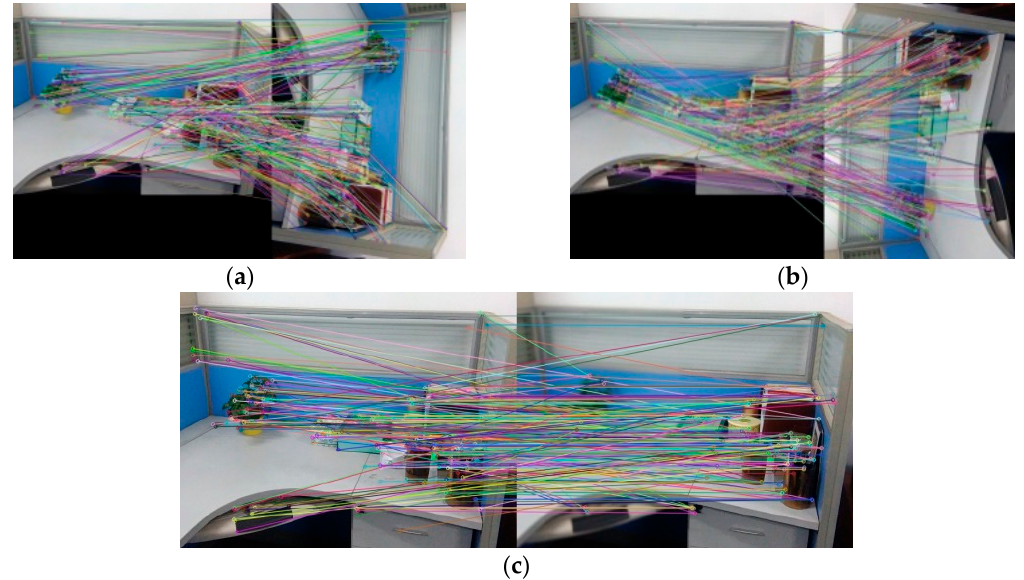
Figure 9. The registration after rotating reference image: ( a ) Rotating 90°; ( b ) Rotating 270°; ( c ) Rotating 180°. Table 4. The correct matching number of reference image after rotating.